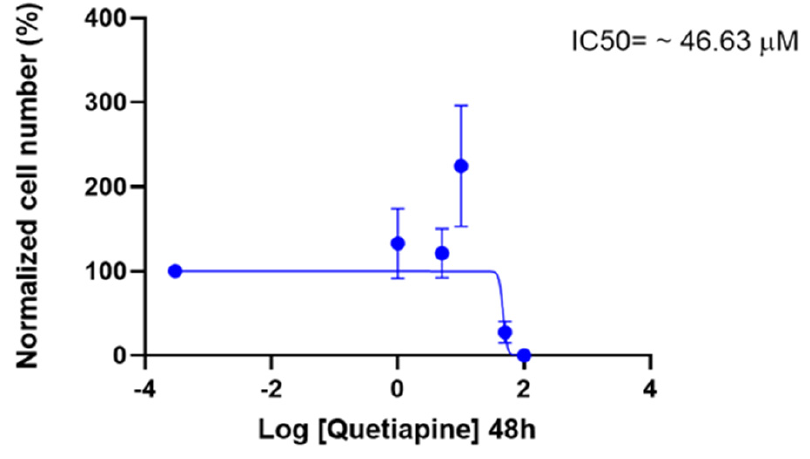
Figure 9. Representation of quetiapine dose-response curve at 48 h. The curve represents a normal- ization between 0 and 100%, where 100% was defined as the concentration of the drug that least affected the cell viability, and 0% was considered the concentration that most affected the cell viability. Results are expressed as mean ± standard error of the mean (SEM). The IC50 value was calculated using the normalized data (between 0% and 100%). The cells were exposed to each of these drugs: selegiline, rasagiline, 2-PCPA and m-CPBH, separately, for 48 h. However, no significant effect on cell viability was noticed in MCF-7 cells with any of them (Figure 10). Consequently, these four drugs were excluded from further